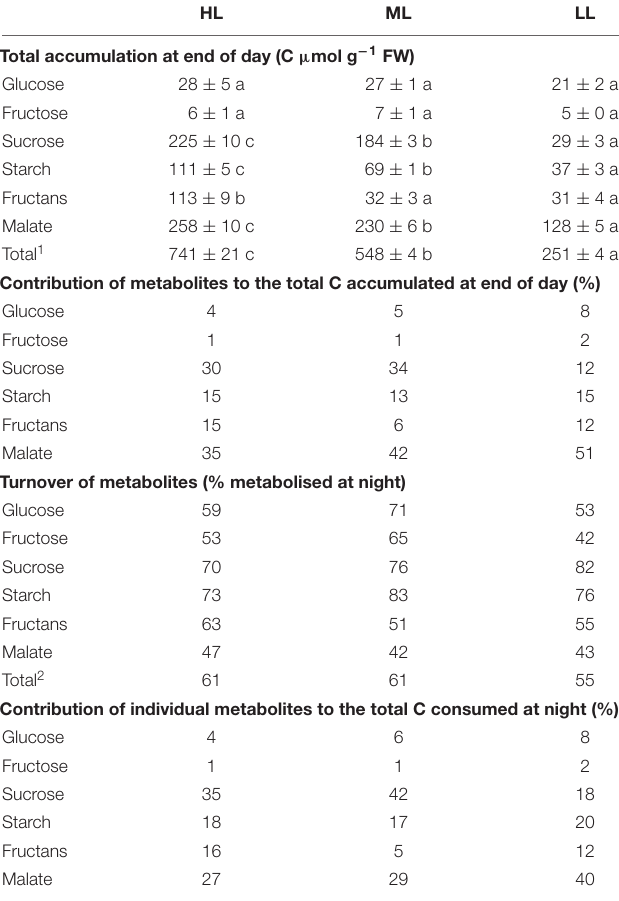
TABLE 3 | Accumulation and mobilization of C reserves in cv. Propino